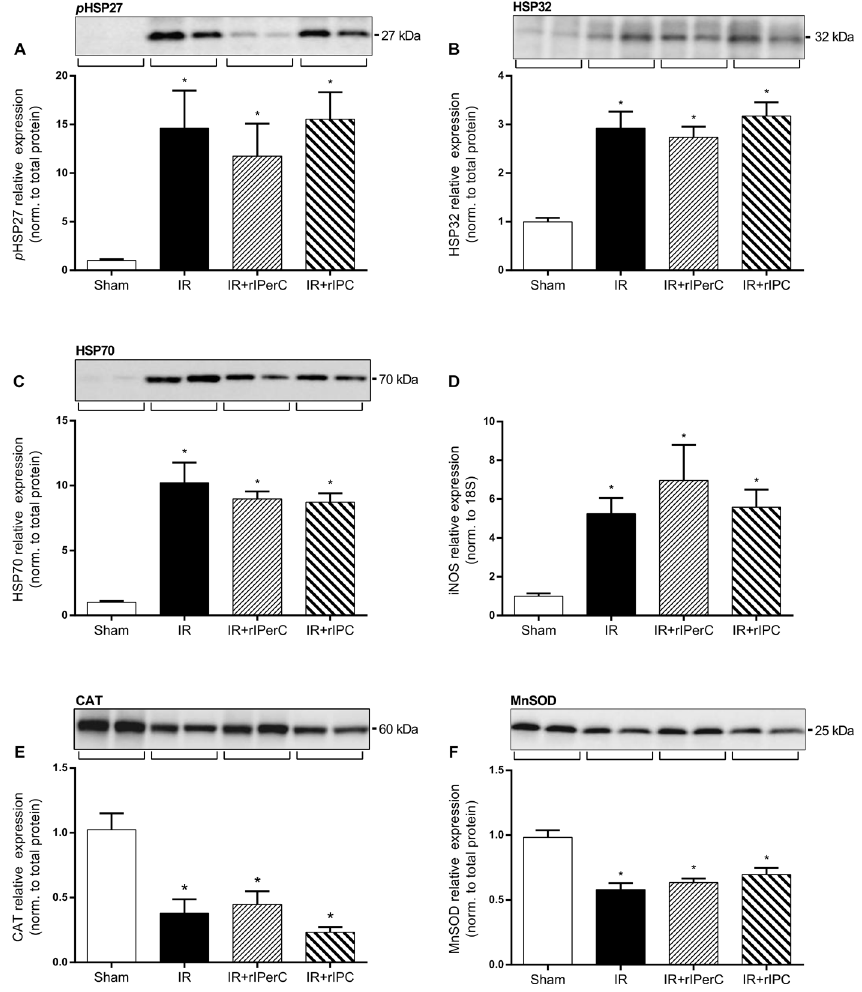
Fig 4. Effect of ischemia-reperfusion injury and remote ischemic conditioning on heat shock protein and anti-oxidant levels and inducible nitric oxide synthase (iNOS) expression after 7 days of reperfusion. A) Phosphorylated heat shock protein 27 (pHSP27). B) Heat shock protein 32 (HSP32). C) Heat shock protein 70 (HSP70). E) Catalase (CAT). F) Manganese superoxide dismutase (MnSOD). Bars represent protein levels by western blotting normalised to total protein. All values are expressed as mean ± SEM. Number of animals (all proteins): sham (n = 7), ischemia-reperfusion (IR; n = 10), IR and remote ischemic preconditioning (IR+rIPC; n = 10), IR and remote ischemic perconditioning (IR+rIPerC; n = 10). Representative western blots (n = 2 in all groups). D) Inducible nitric oxide synthase (iNOS). Bars represent mRNA levels by quantitative polymerase chain reaction in left renal cortex/outer medulla normalised to 18S mRNA. All values are expressed as mean ± SEM. Group means were compared using one-way analysis of variance followed by Bonferroni ’ s multiple comparison post-test. * P < 0.05 vs. sham. Number of animals: sham (n = 7), IR (n = 10), IR+rIPC (n = 10), IR+rIPerC (n =